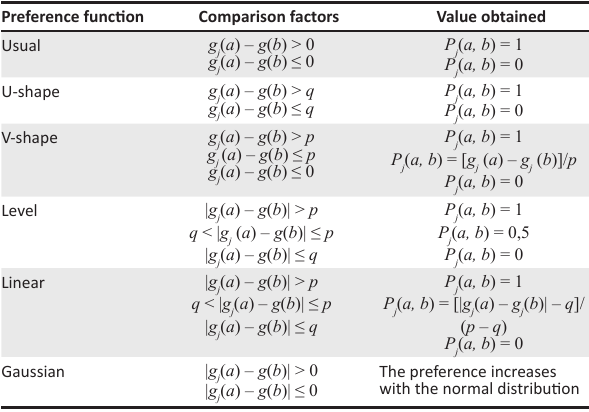
TABLE 3: Preference functions. Preference function Comparison factors Value obtained